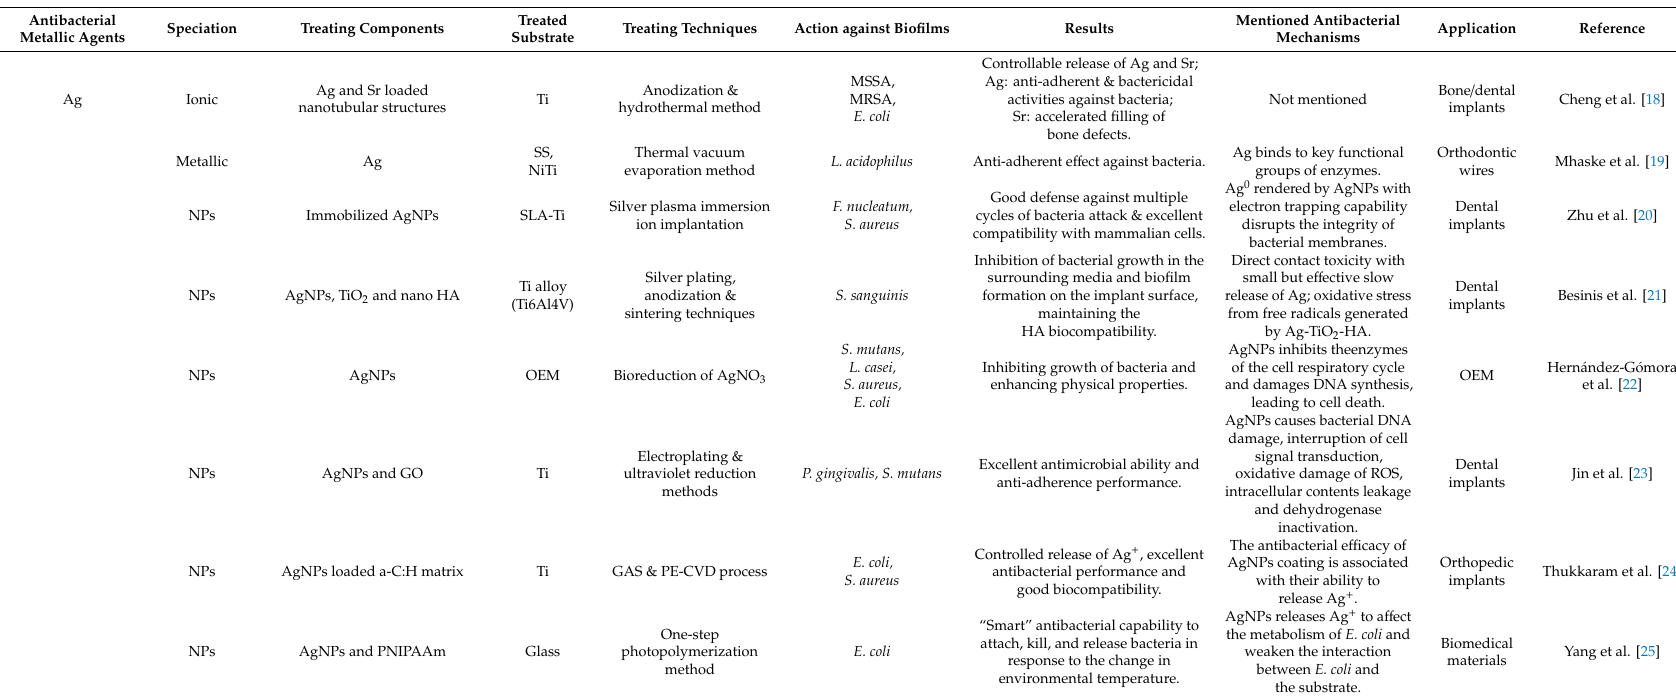
Table 1. Summary on researches about metallic antibacterial surface treatments of dental and orthopedic